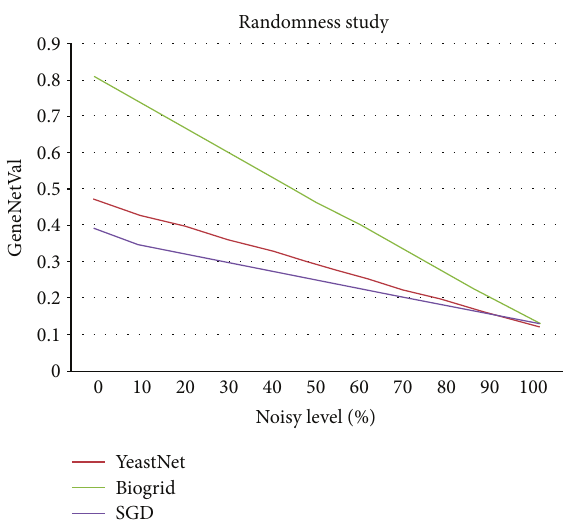
Figure 7: Results of the randomness study of GeneNetVal using level 2. For this study, we have used different yeast networks versus pathway